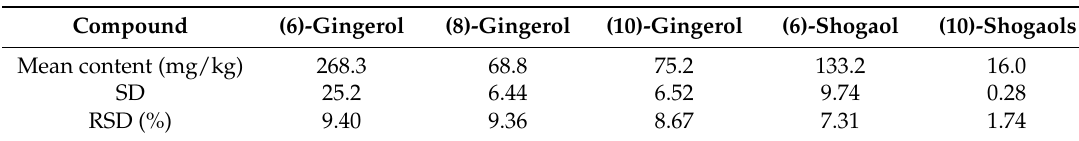
Table 2. Average content of the major phenolic compounds in fresh ginger rhizomes cultivated on ecological plantations in Japan.